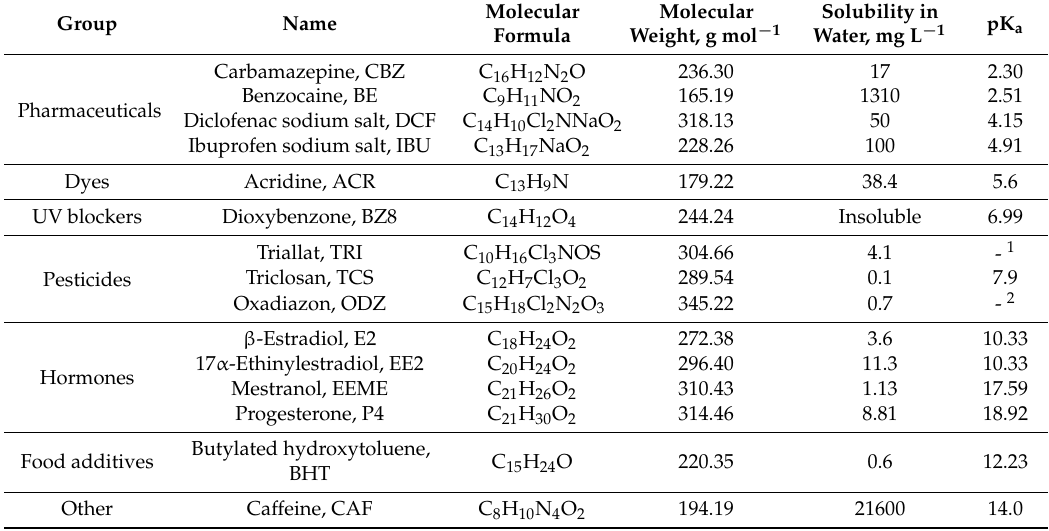
Table 1. Characteristics of the tested organic compounds